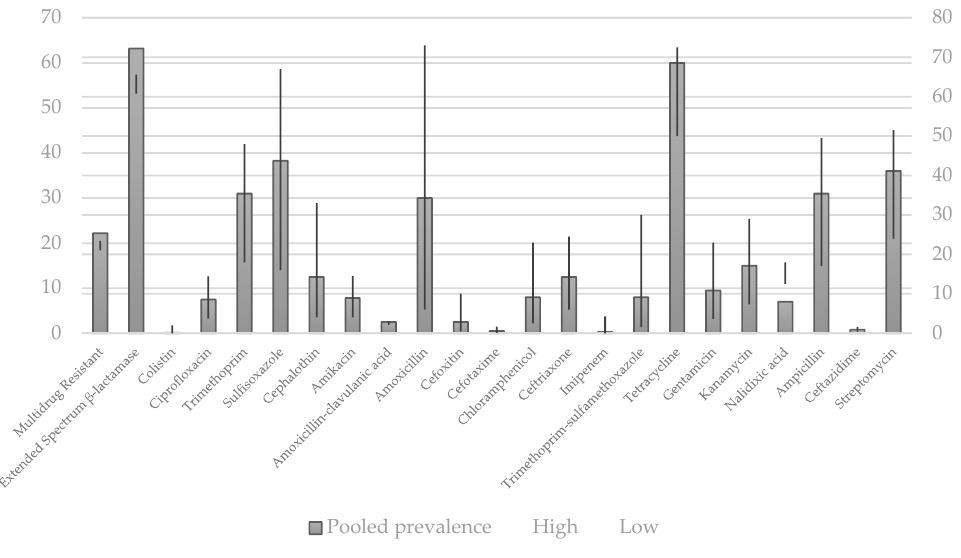
Figure 5. Pooled prevalence of antibiotic resistance isolates in pet animals by minimum inhibitory concentration, % [161].